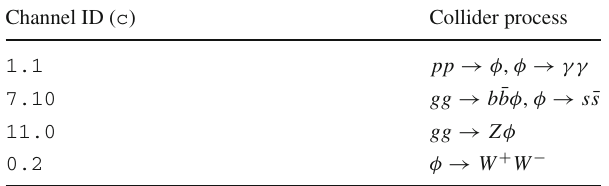
Table 2 Examples for processes encoded by the